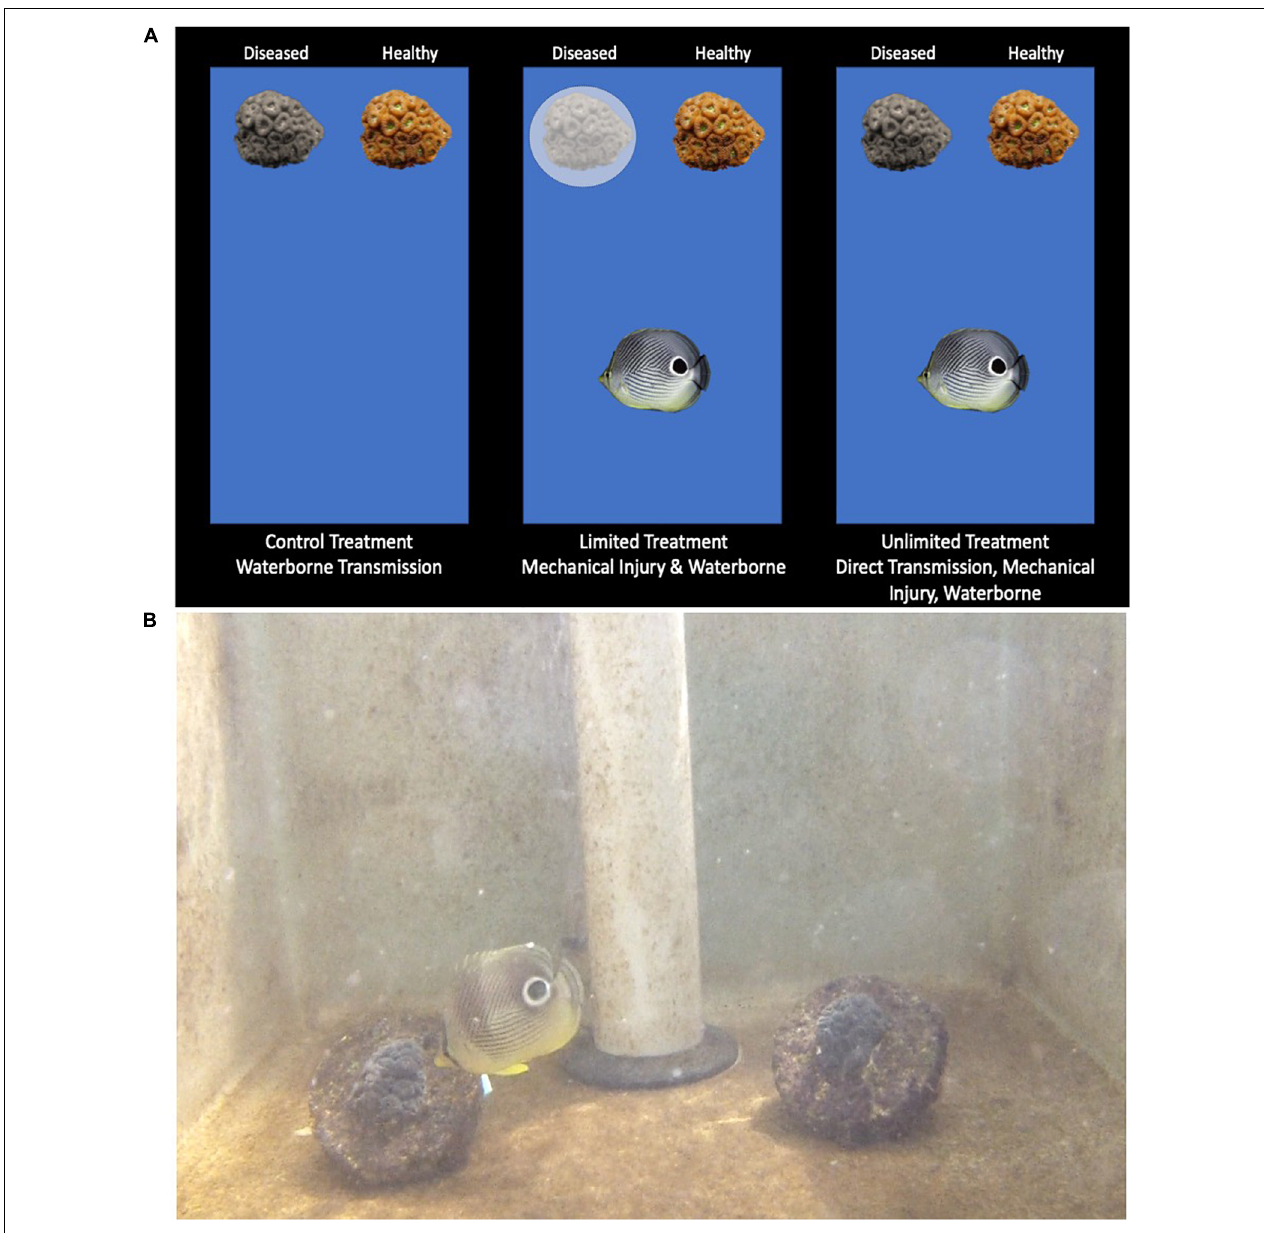
FIGURE 2 | Three treatments were used for the transmission experiment: control (waterborne), limited (mechanical injury and waterborne), and unlimited (direct feeding transfer, mechanical injury, waterborne) (A) . Foureye butterflyfish feeding on the diseased coral fragment in the unlimited treatment (B) .